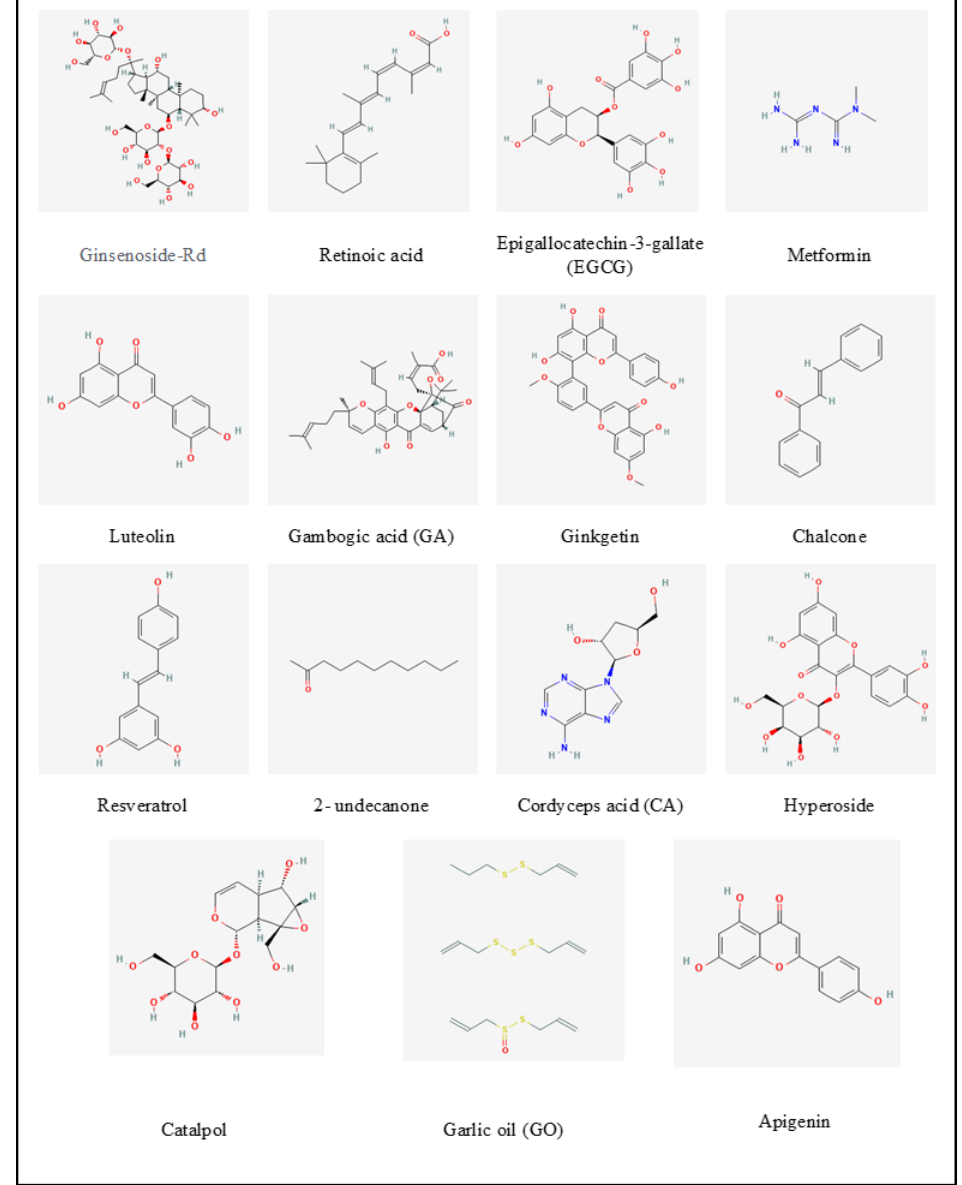
Figure 6. Collection of natural antioxidant compounds with a special effect on the Nrf2/HO-1 axis. Table 1. Nrf2/HO-1 axis targeting by natural compounds in vitro and in vivo.